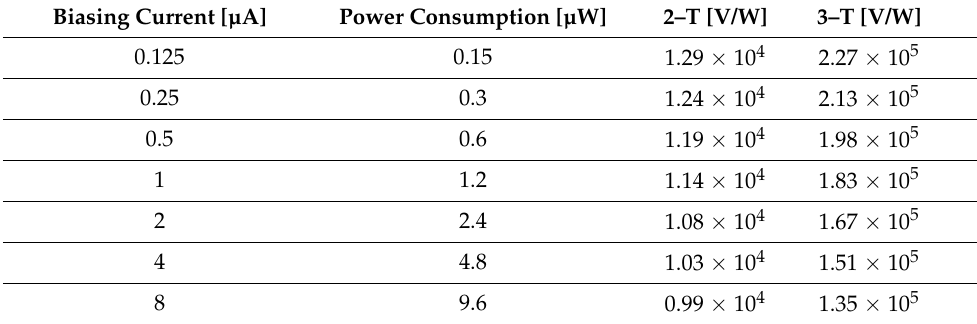
Table 2. Simulated TMOS responsivity.